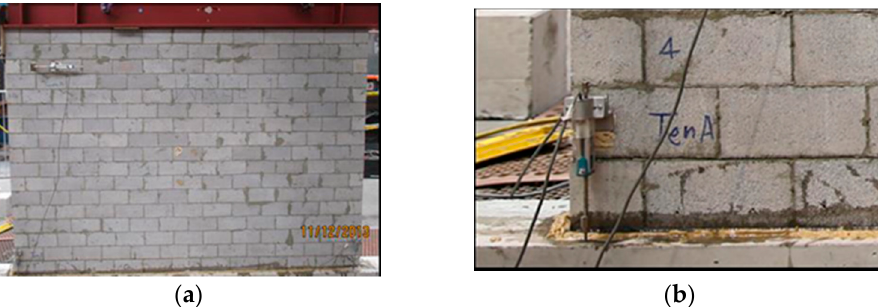
Figure 8. In-plane shear wall testing of TLM masonry walls [72]: ( a ) in-plane shear testing arrangement and ( b ) sliding failure of a TLM wall.